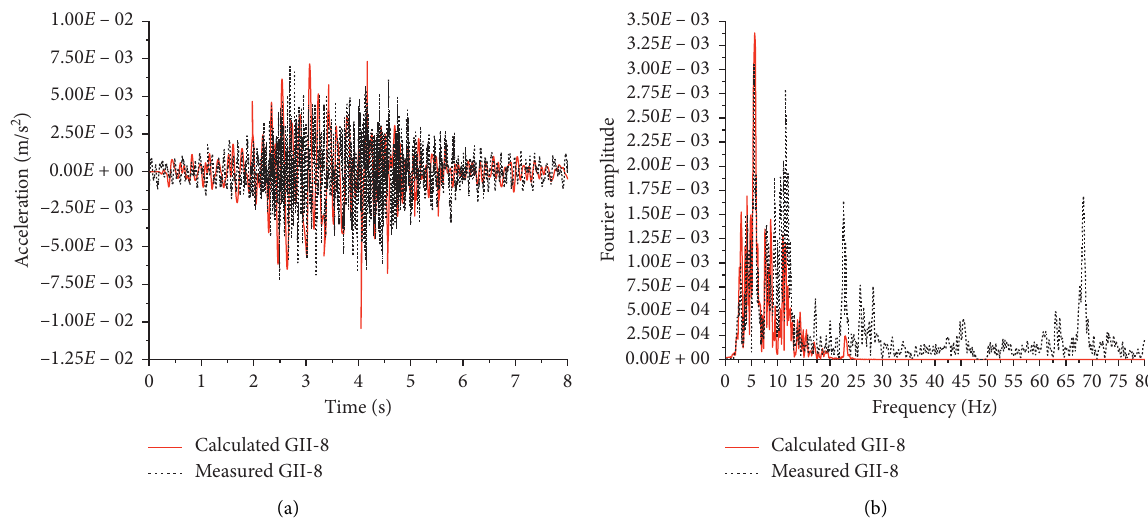
Figure 17: Comparison of numerical and field results (GII-8): (a) acceleration time history; (b) frequency spectrum.